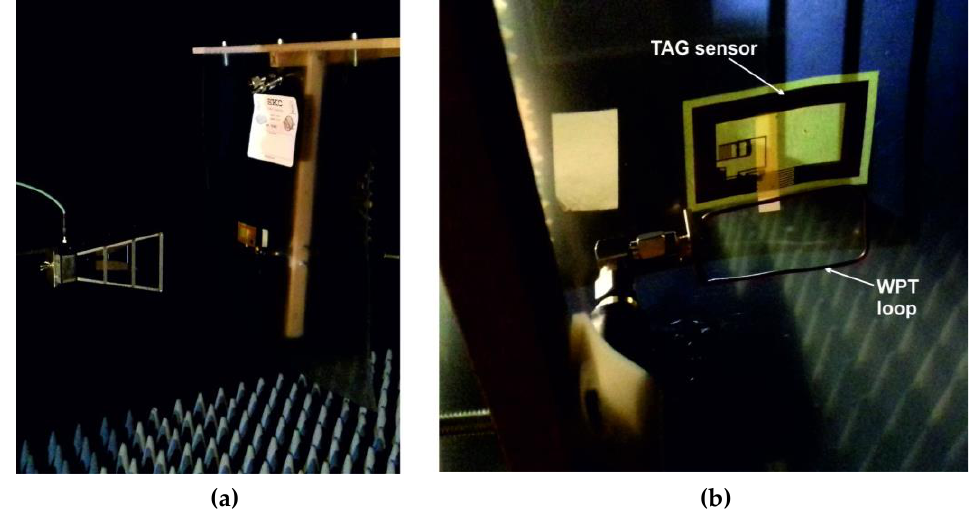
Figure 11. Measurement setup in an anechoic chamber: ( a ) front view of RFID tag and measuring antenna; ( b ) back view of RFID tag and WPT loop.